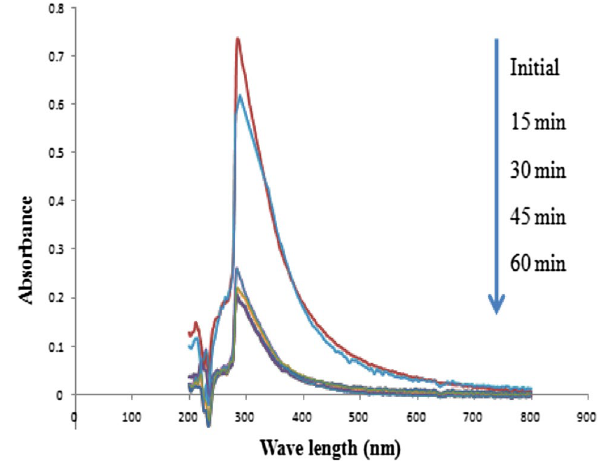
Fig. 5 Spectra of landfill leachate wastewater, recorded before and after the electrocoagulation process at different electrolysis